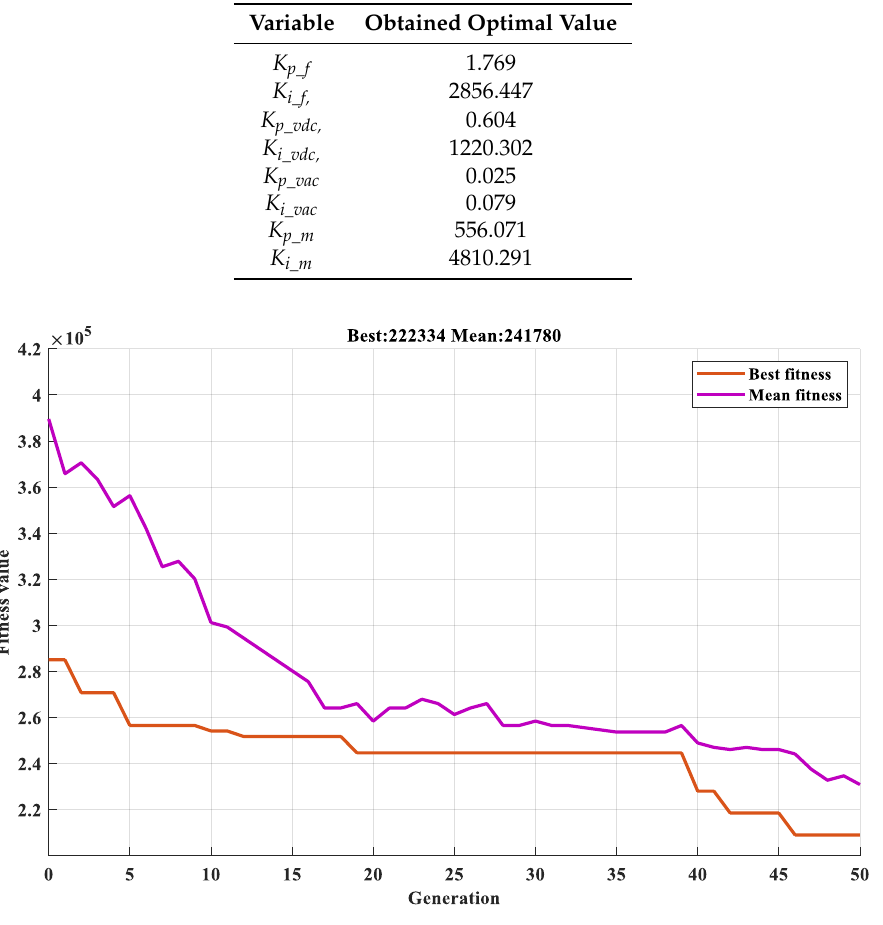
Figure 10. The optimization results of the proposed hybrid algorithm. Table 2. The optimal control parameters. Variable